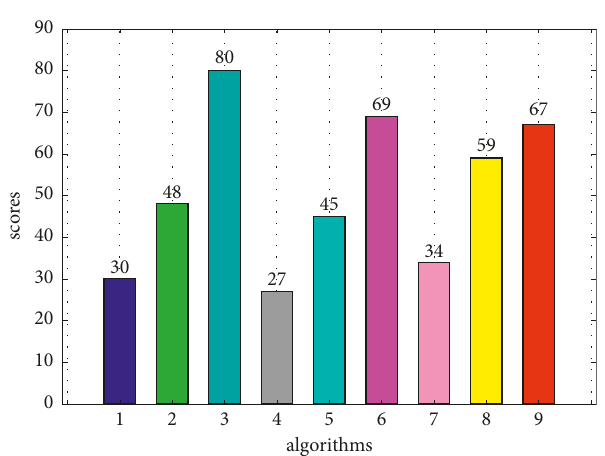
Figure 4: The bar chart of HHs scored on C1.